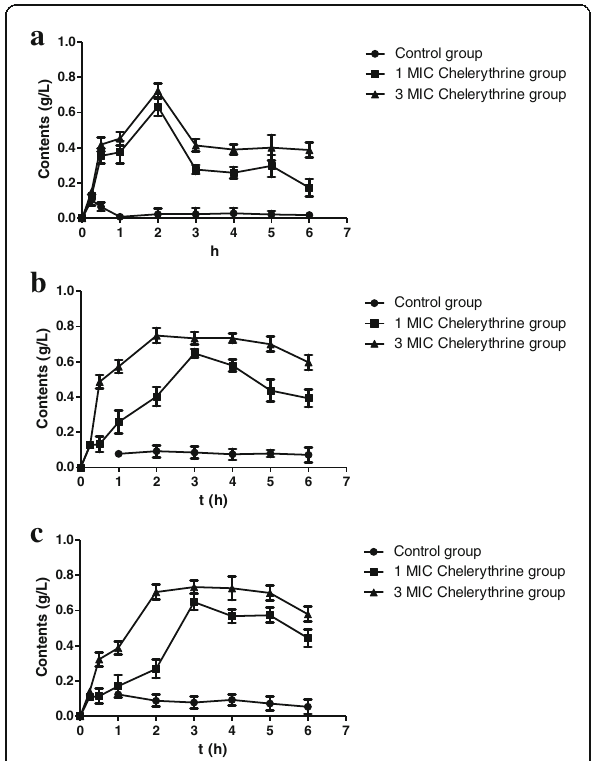
Fig. 3 Changesinthe soluble protein concentration against SA ( a ), MRSA ( b ) and ESBLs-SA( c